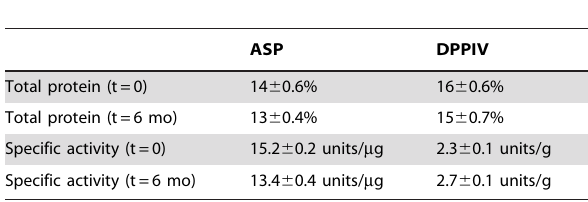
Table 1. Protein content and specific activity of aspergillopepsin (ASP) and dipeptidyl peptidase IV (DPPIV) preparations used in this study.